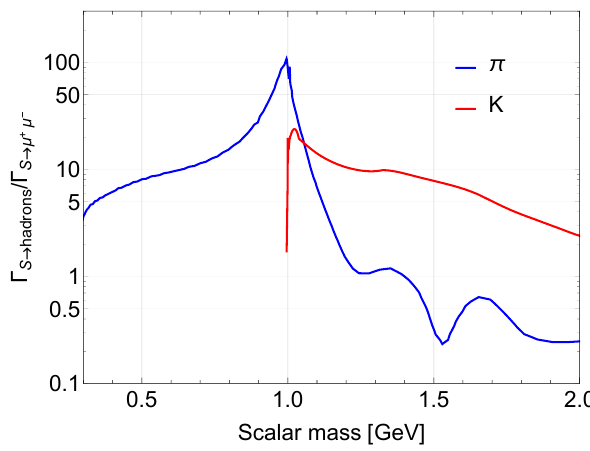
Figure 9 . The ratio of the decay widths of a light scalar into pions, kaons and into muons obtained in [32]. We summed over all (cid:12)nal meson states, i.e. for decays into pions we summed over (cid:25) + (cid:25) (cid:0) ; (cid:25) 0 (cid:25) 0 . A peak in the decay width corresponding to the channel S is caused by the narrow f 0 (980) resonance.